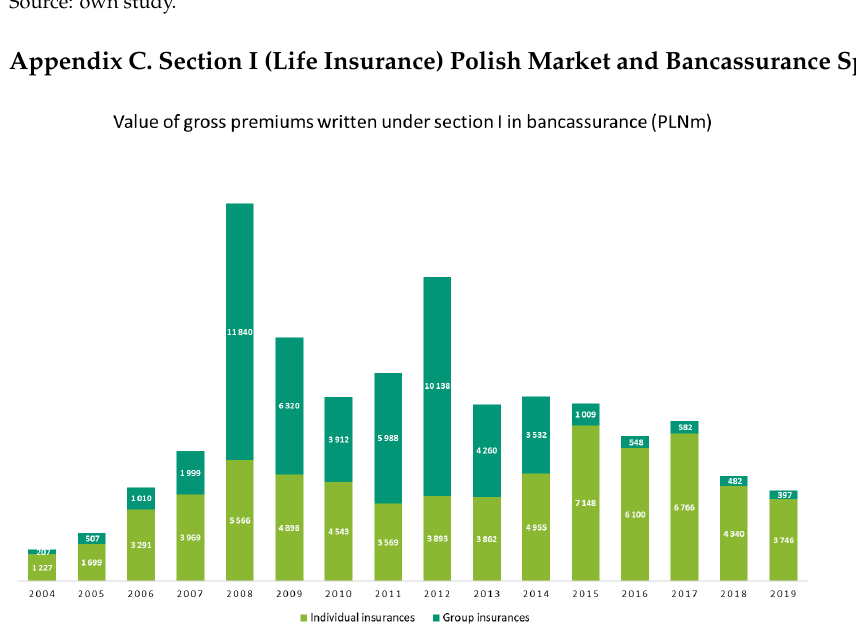
Figure A1. Value of gross premiums written in the bancassurance channel, source: own study based on KNF’s data: (Polish Financial Supervision Authority 2001–2019).